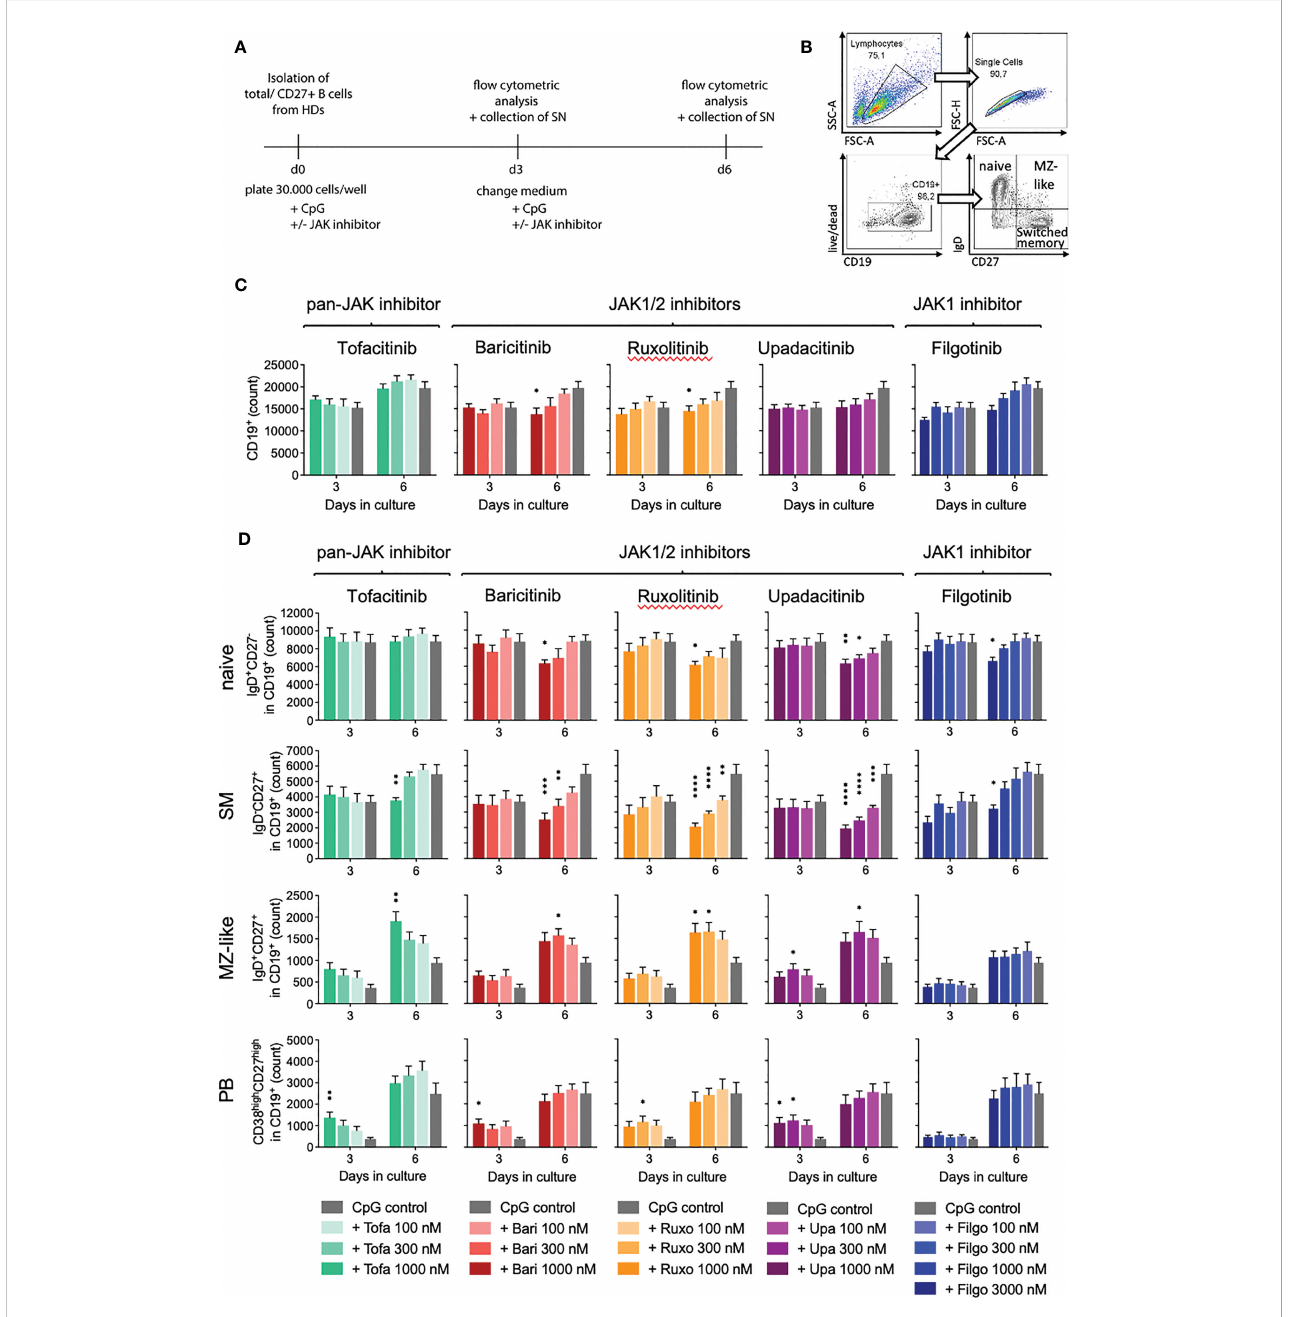
FIGURE 2 Impact of JAK inhibition on B cell differentiation in T-independent in-vitro culture. Primary total B cells were activated with CpG on day 0 and cultured in the absence or presence of indicated concentrations of JAK inhibitors. On day 3 and 6, B cell subpopulations were analyzed by time acquisitioned fl ow cytometry. (A) : Experimental set-up for in-vitro culture model of T-cell-independent B cell activation with CpG, known to support MZ B cell expansion. (B) : Gating strategy. Lymphocytes were de fi ned by the cell size/granularity. After exclusion of doublets and dead cells, live CD19+ cells were de fi ned as B cells. Among these, naive, MZ, and memory B cells were de fi ned by IgD and CD27 expression and plasmablasts by expression of CD38 and CD27. (C) : Total B cell count depicted in absence or presence of JAK inhibitors. Data shown as mean ± SEM of 4 independent experiments, with triplicates each; (D) : Absolute numbers of naive (IgD+CD27-), memory (IgD-CD27+), and MZ B cells (IgD+CD27+), as well as plasmablasts (CD38highCD27high) within the live/CD19+ population. Data shown as mean ± SEM of 4 independent experiments, each in triplicate. ANOVA with Dunnett ’ s multiple comparisons test as follow-up test. *p < 0.05, **p < 0.005, ***p < 0.0005, ****p < 0.0001 indicate signi fi cant differences of JAK inhibitors compared to CpG